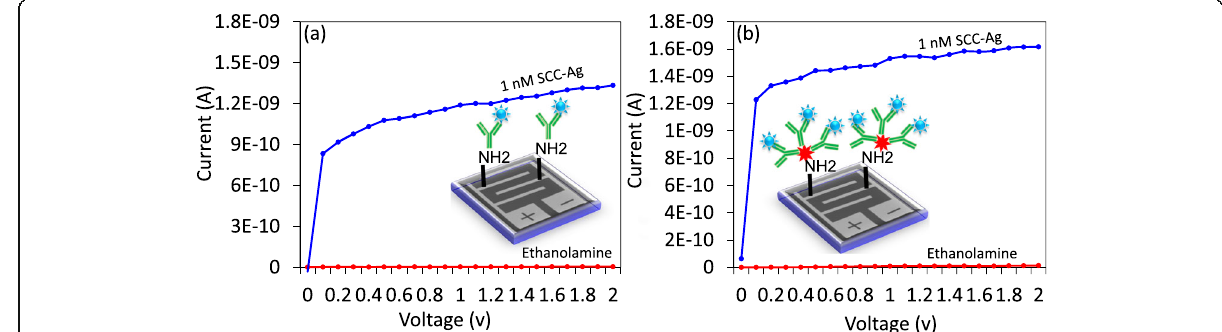
Fig. 4 SCC-Ag detection with a antibody and b GNS antibody. Tested on IDE-TiO 2 surfaces with the above steps until 1 M of ethanolamine blocking. A linear sweep voltage of 0 to 2 V at 0.01 V step voltage was followed for the measurements. After interacting 1 nM of SCC-Ag, the current levels were increased in both cases; at the same time, it shows a higher current change with GNS antibody